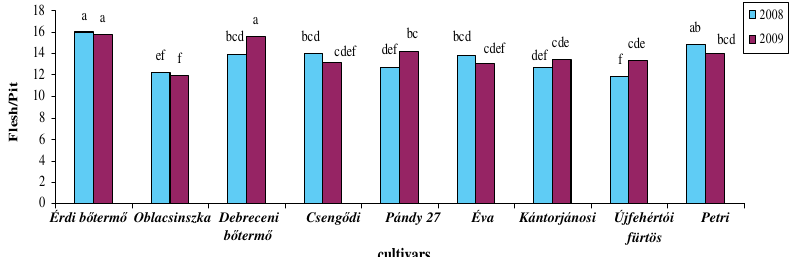
Figure 10. Flesh/Pit ratios of the studied sour cherry cultivars in tow years (2008 & 2009). Different letters indicate significant differences between treatments (P